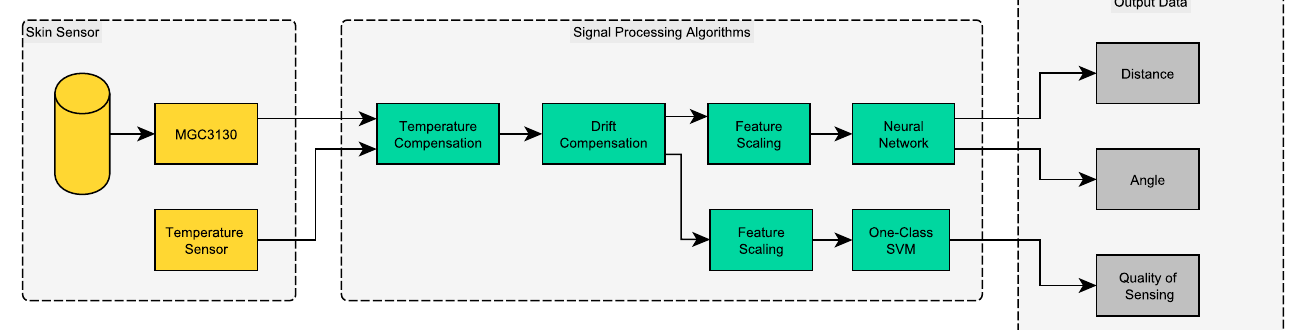
Figure 1. System architecture and signal processing diagram for data fusion and data quality indication. The sensor skin provides the measured physical properties as digital values to the system. Yellow blocks indicate physical parts, green blocks are algorithms implemented in software, gray blocks are signal